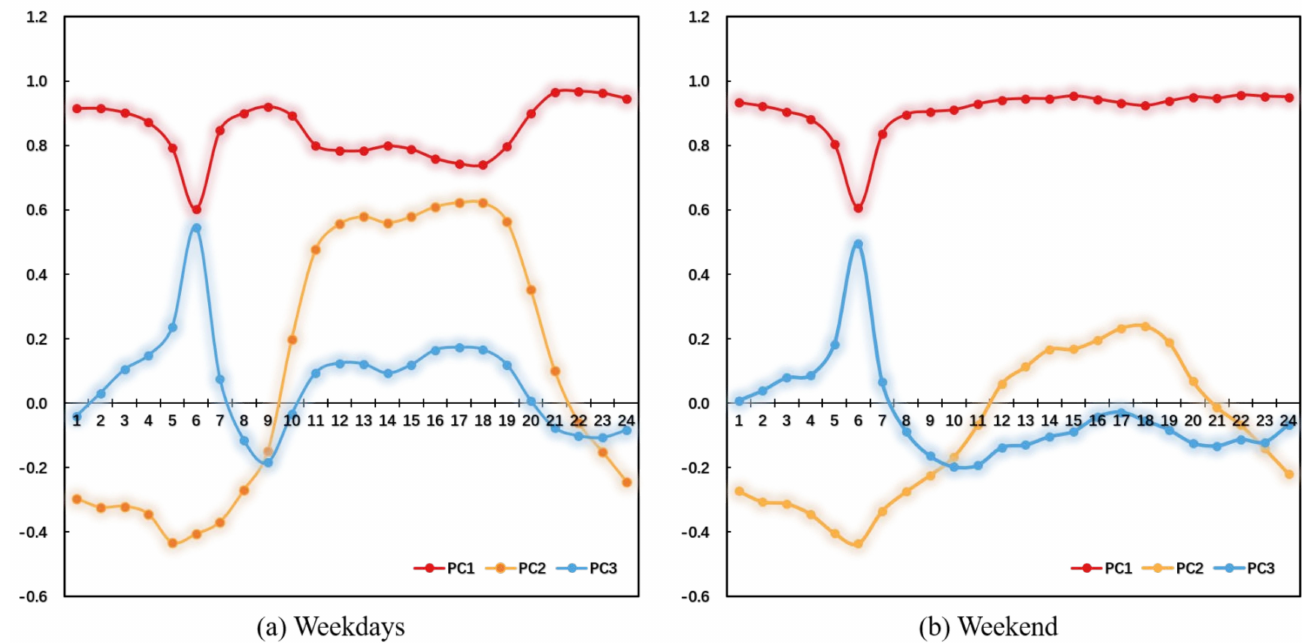
Figure 3. Results of the eigendecomposition. ( a ) PCs on weekdays, ( b ) PCs on weekend. The resultant PCs, ranked by the fraction of the variance explained, indicated the hidden structure of the TUD dataset. The corresponding coefficients associated with a particular entity (e.g., temporal population activity pattern in a building) demonstrate